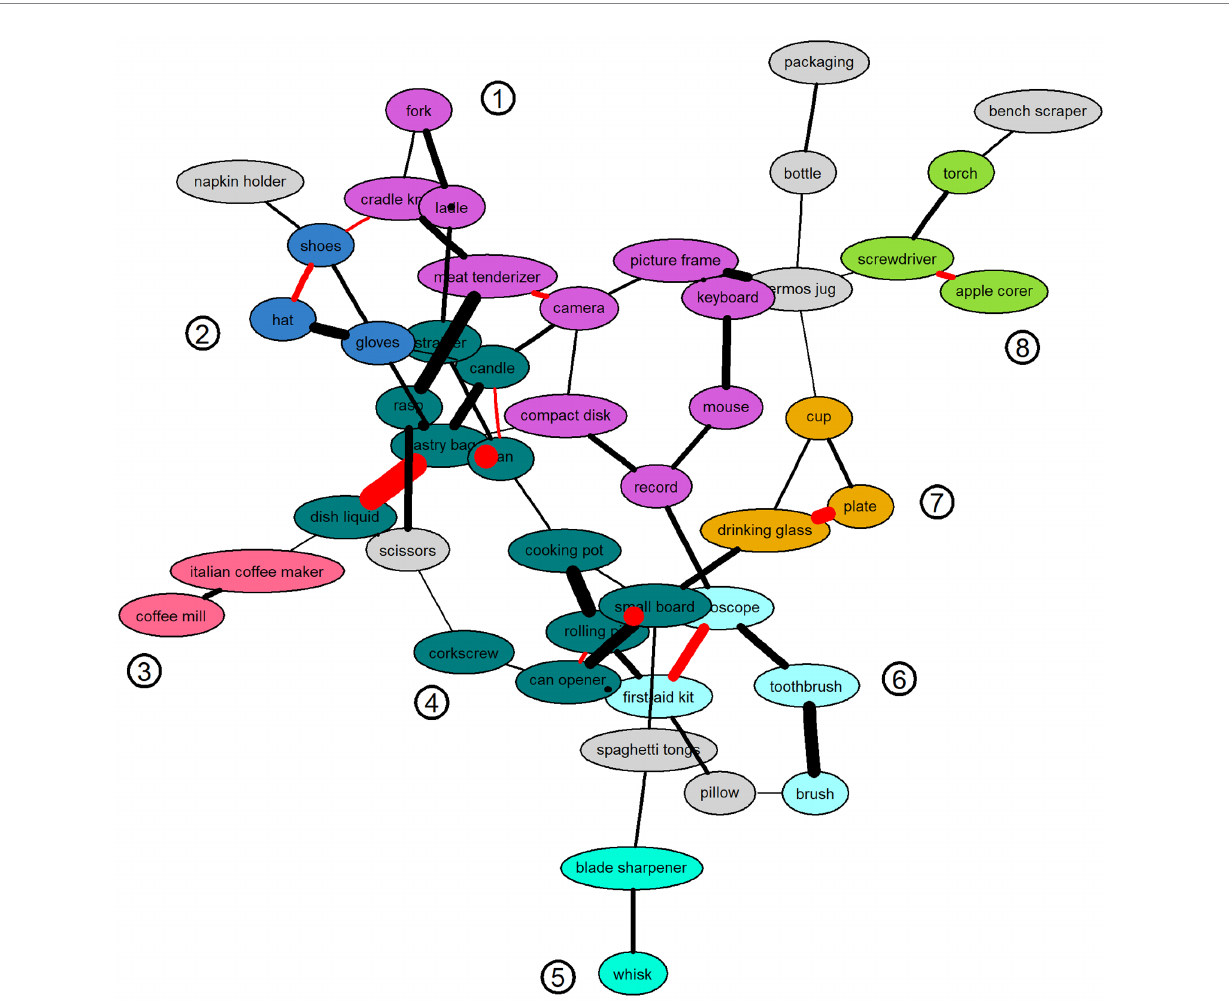
FIGURE 1 Memory association graph of objects encoded across five trials of free recall in healthy older adults (HOA). Note: Vertex color denotes subgraphs (numbered cliques) that both the HOA and the YA graphs have in common. Cliques are consistent with the following semantic grouping principles: cutlery hyponyms and media devices bridged by a serial association (1), clothes (2), coffee tools (3), objects from then primacy and recency portion (4), kitchen tools made of the same material (5), medical instruments and one hyperonym (6), dinnerware (7), and tools or shape (8). Red edges indicate consecutive serial list positions and edge width indicates a higher strength of association (smaller likelihood) as the width increases. Grayed vertices denote unassigned objects.